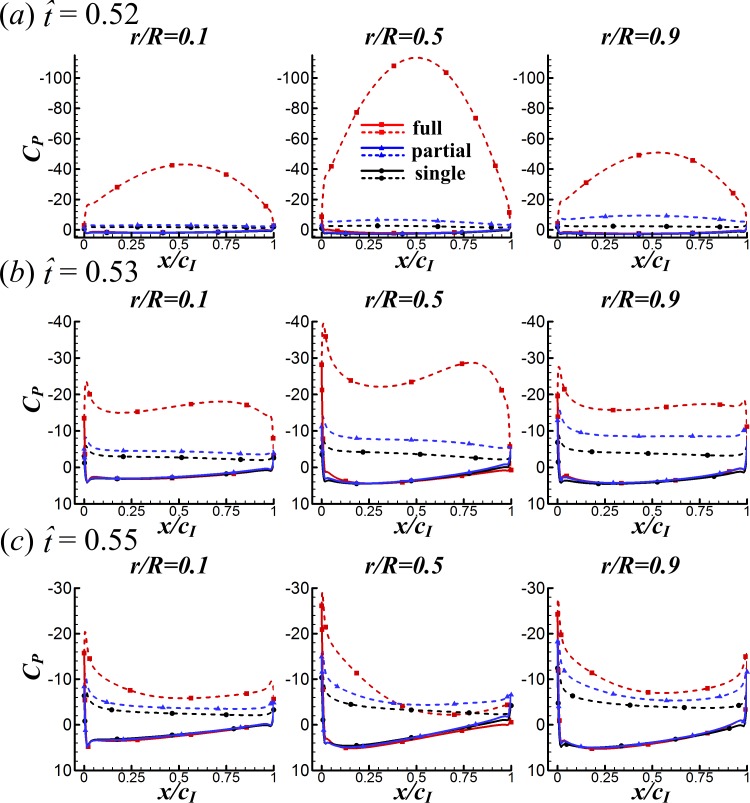
Surface pressure distributions of the three cases at various spanwise positions for \documentclass[12pt]{minimal}
\usepackage{amsmath}
\usepackage{wasysym}
\usepackage{amsfonts}
\usepackage{amssymb}
\usepackage{amsbsy}
\usepackage{upgreek}
\usepackage{mathrsfs}
\setlength{\oddsidemargin}{-69pt}
\begin{document}
}{}$\hat {t}=0.52$\end{document}t ˆ=0.52, 0.53 and 0.55 (solid and broken lines indicate the pressure distribution on the lower surface and the upper surface, respectively).